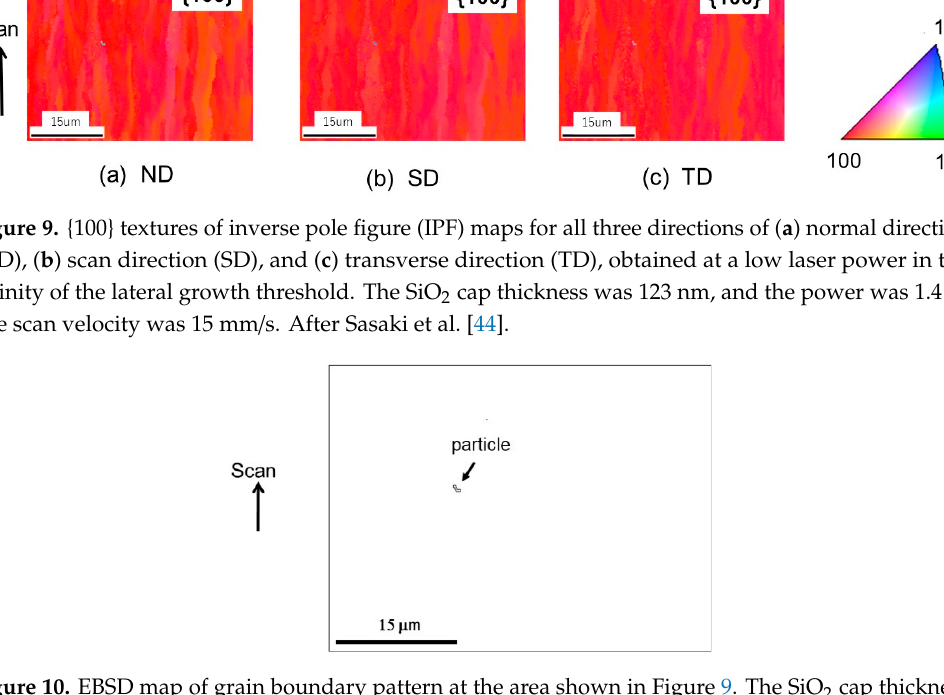
Figure 10. EBSD map of grain boundary pattern at the area shown in Figure 9. The SiO 2 cap thickness was 123 nm, and the power was 1.4 W. The scan velocity was 15 mm/s. After Sasaki et al. [49].